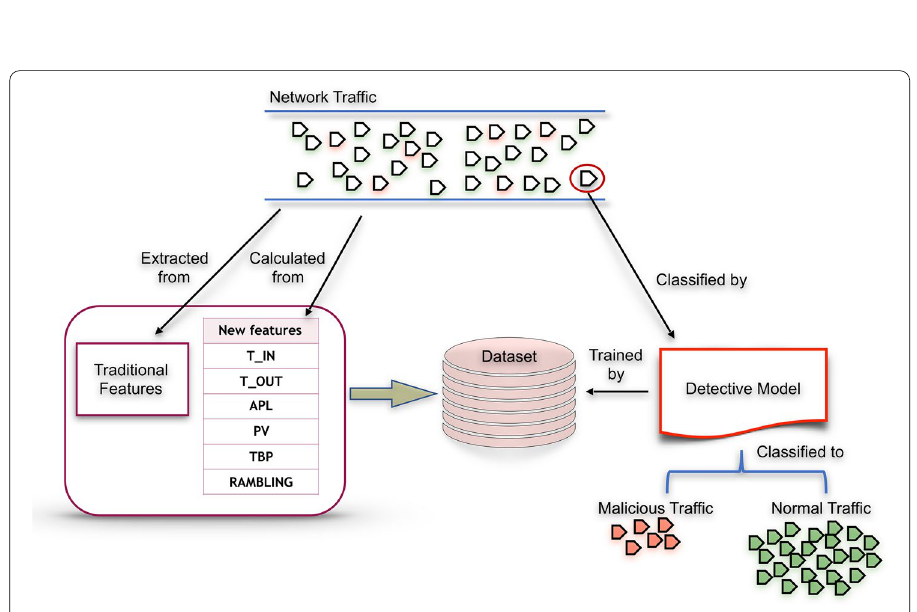
Fig. 3 Detection